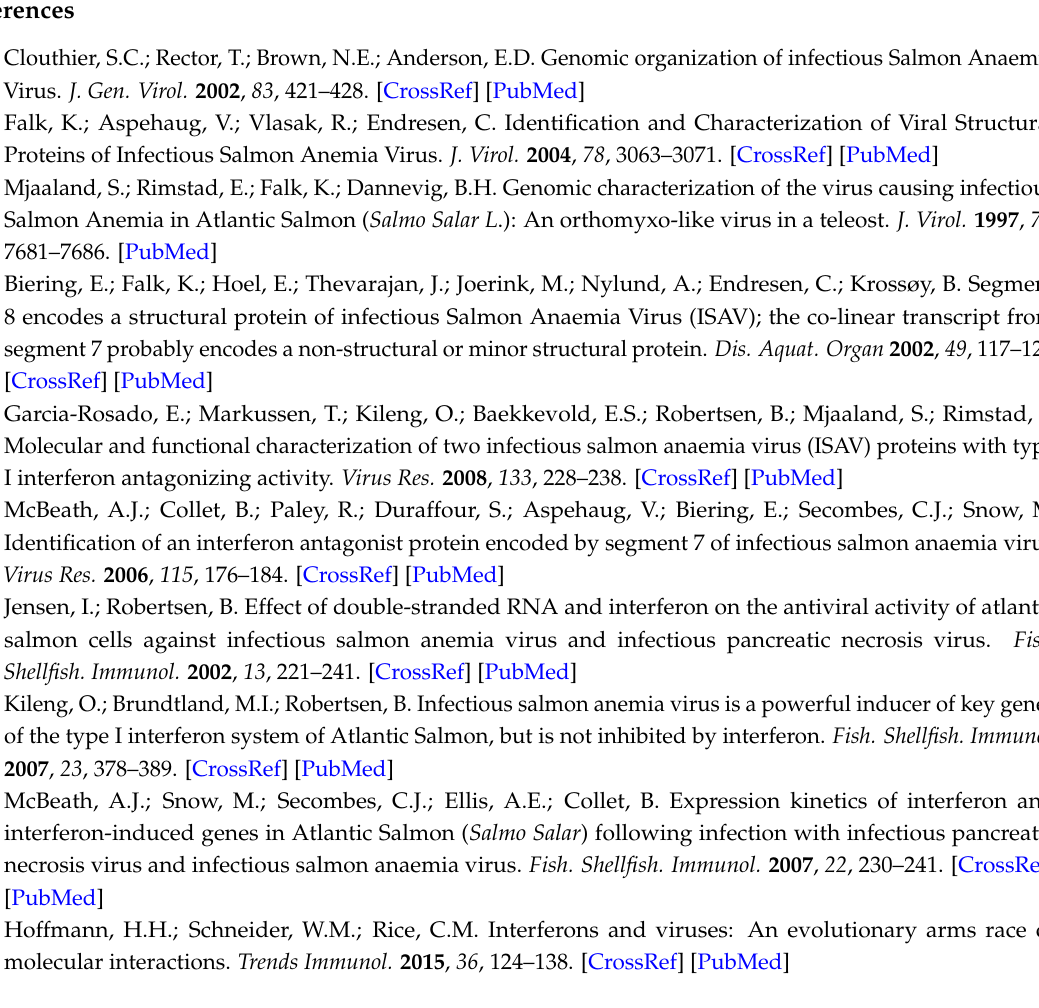
Figure S1: S8ORF2 protein is present in both the cytosol and nucleus of some ISAV infected ASK cells, Figure S2: Nucleo-cytoplasmic shuttling is not affected when s8ORF2-EGFP transfected cells are treated with Leptomycin B to inhibit CRM-1 dependent nuclear export, Figure S3: Western blot of co-immunopresipitation (IP) assays with s8ORF2 and F